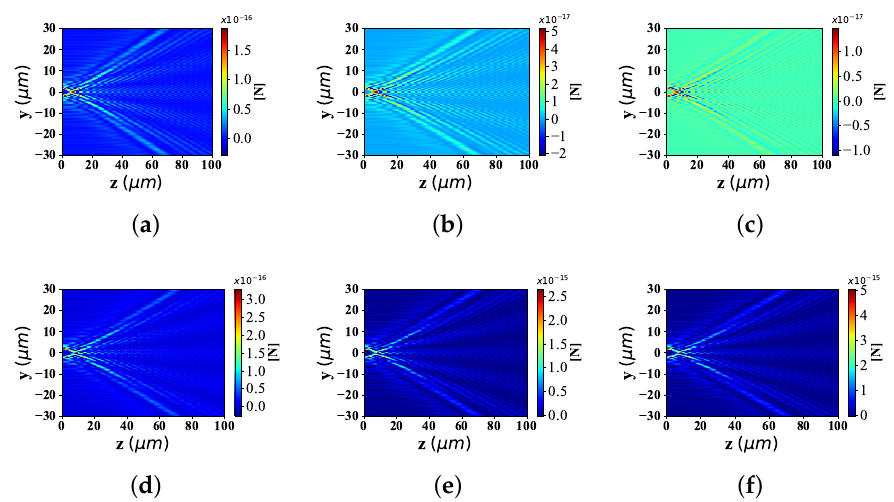
Figure 11. Distribution of F z under different refractive indices ( m 1 = 1.0, 1.2, 1.3, 1.8, 2.8, 3.8) for the interaction of Bessel pincer light-sheets beam on the spherical particle. ( a ) m 1 = 1.0; ( b ) m 1 = 1.2; ( c ) m 1 = 1.3; ( d ) m 1 = 1.8; ( e ) m 1 = 2.8; ( f ) m 1 =